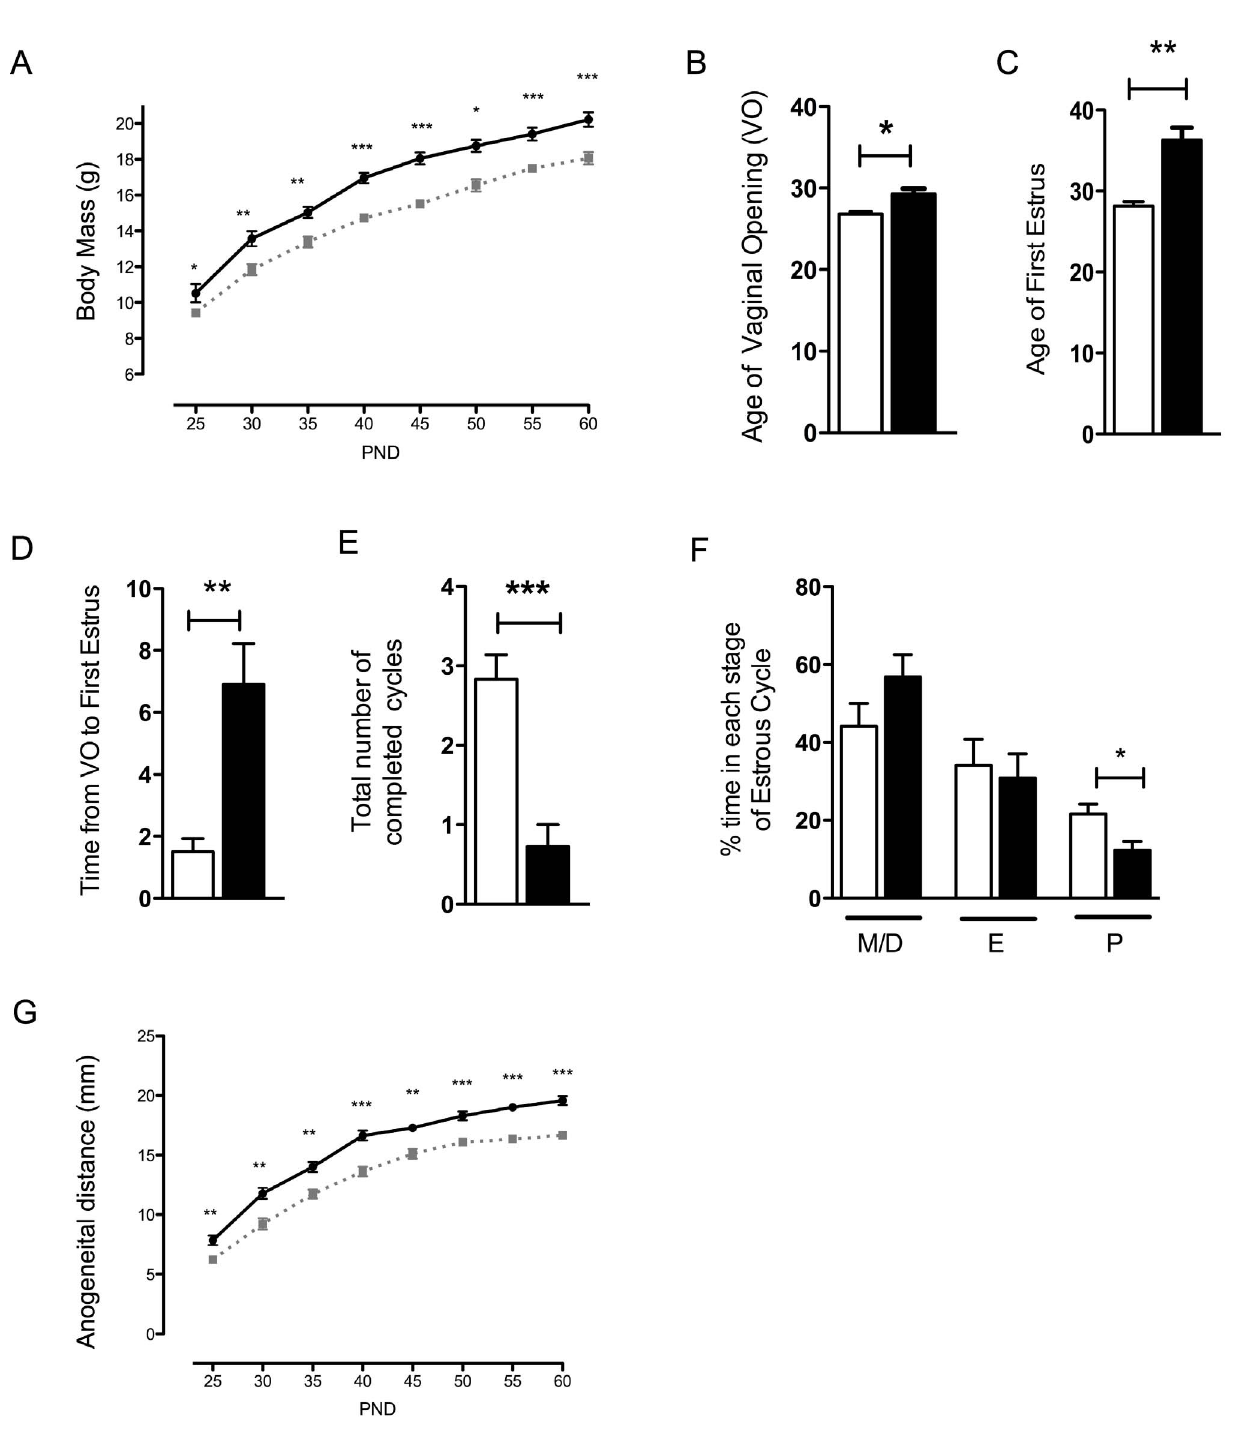
Figure 4. Female Nes-cre;Dmxl2 –/wt mice displayed delayed puberty and were infertile. (A) Postnatal growth curve of female nes- Cre ; Dmxl2 –/wt mice (black line, Dmxl2 lox/wt ; hatched gray line, nes-Cre ; Dmxl2 –/wt ). (B and C) VO and first estrus occurred significantly later in female nes- Cre ; Dmxl2 –/wt mice than in their WT littermates. (D) The interval from VO to first estrus was significantly longer in female nes-Cre ; Dmxl2 –/wt mice than in WT mice, suggesting a defect in maturation of the HPG axis. (E) Very few complete estrous cycles were observed in female nes-Cre ; Dmxl2 –/wt mice. (F) Female nes-Cre ; Dmxl2 –/wt spent less time in high estradiol concentration (M, miestrus; E, estrus; D, diestrus; P, proestrus). (G) A significant difference in AGD was observed between male nes-Cre ; Dmxl2 –/wt mice and their WT littermates. Black line, Dmxl2 lox/wt ; hatched gray line, nes- Cre ; Dmxl2 -/wt . White bars, Dmxl2 lox/wt . Black bars, nes-Cre ; Dmxl2 –/wt . Numerical data used to generate graphs 4B, 4C, 4D, 4E, 4F, or graphs 4A, 4G may be found in Table S5 and Table S6, respectively. Error bars are SEM. * p , 0.05, ** p , 0.01, *** p , 0.001.